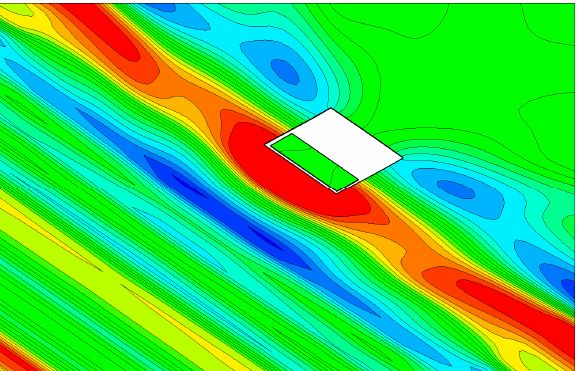
Figure 15. Wave field around the OWC chamber under irregular waves in the three-dimensional numerical wave tank.